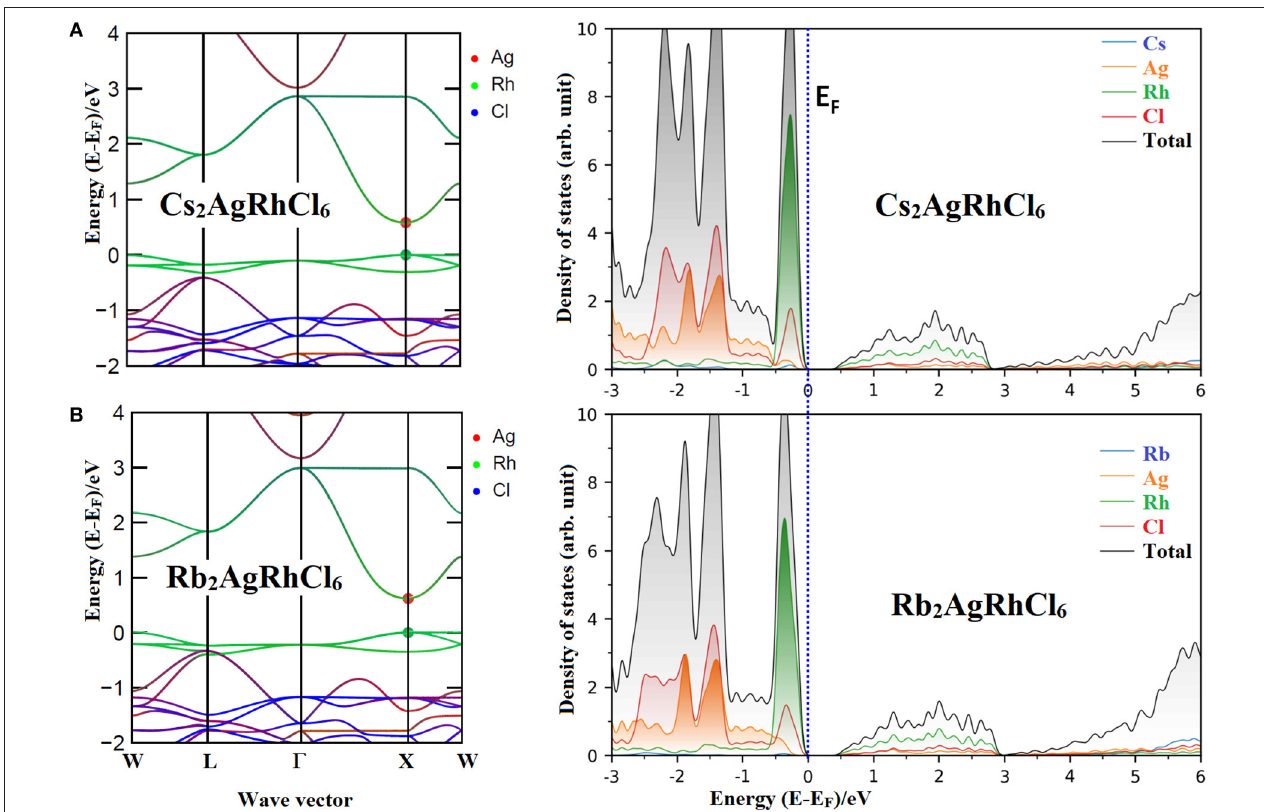
FIGURE 2 | Comparison of the non-spin polarized atom-projected electronic band structure and partial (and total) density of states of (A) Cs 2 AgRhCl 6 with (B) Rb 2 AgRhCl 6 . Different color codes were used for each plot. The k -vector types of space group Fm ¯ 3 m were used for band